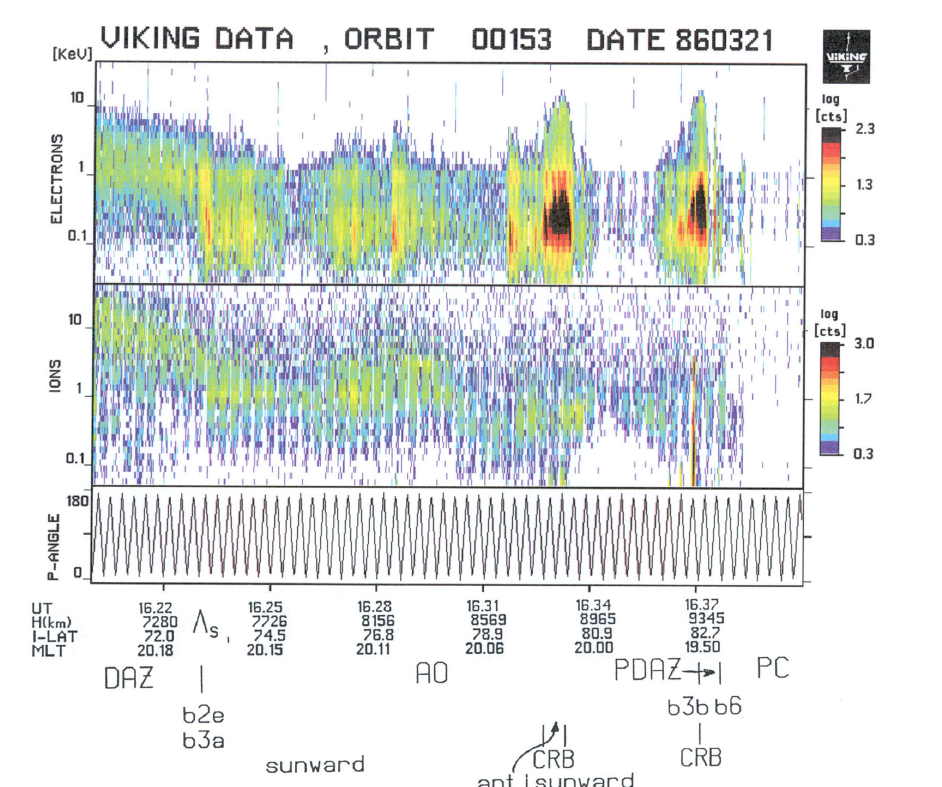
Fig. 12a. The same as Fig. 5a, except for orbit 153 on 21 March 1986, 1620–1736